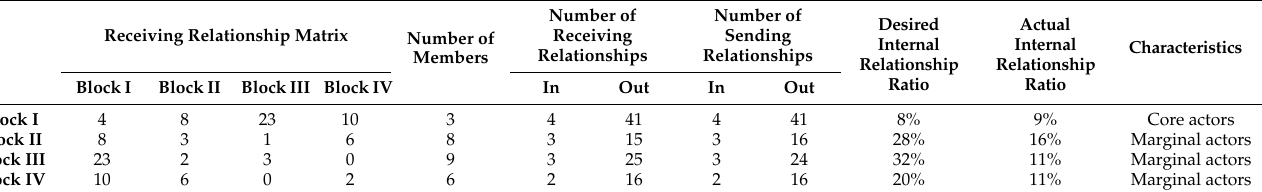
Figure 4. Diagram of block model analysis for 2019. Table 4. Spillover effects of tourism eco-efficiency spatially related blocks in